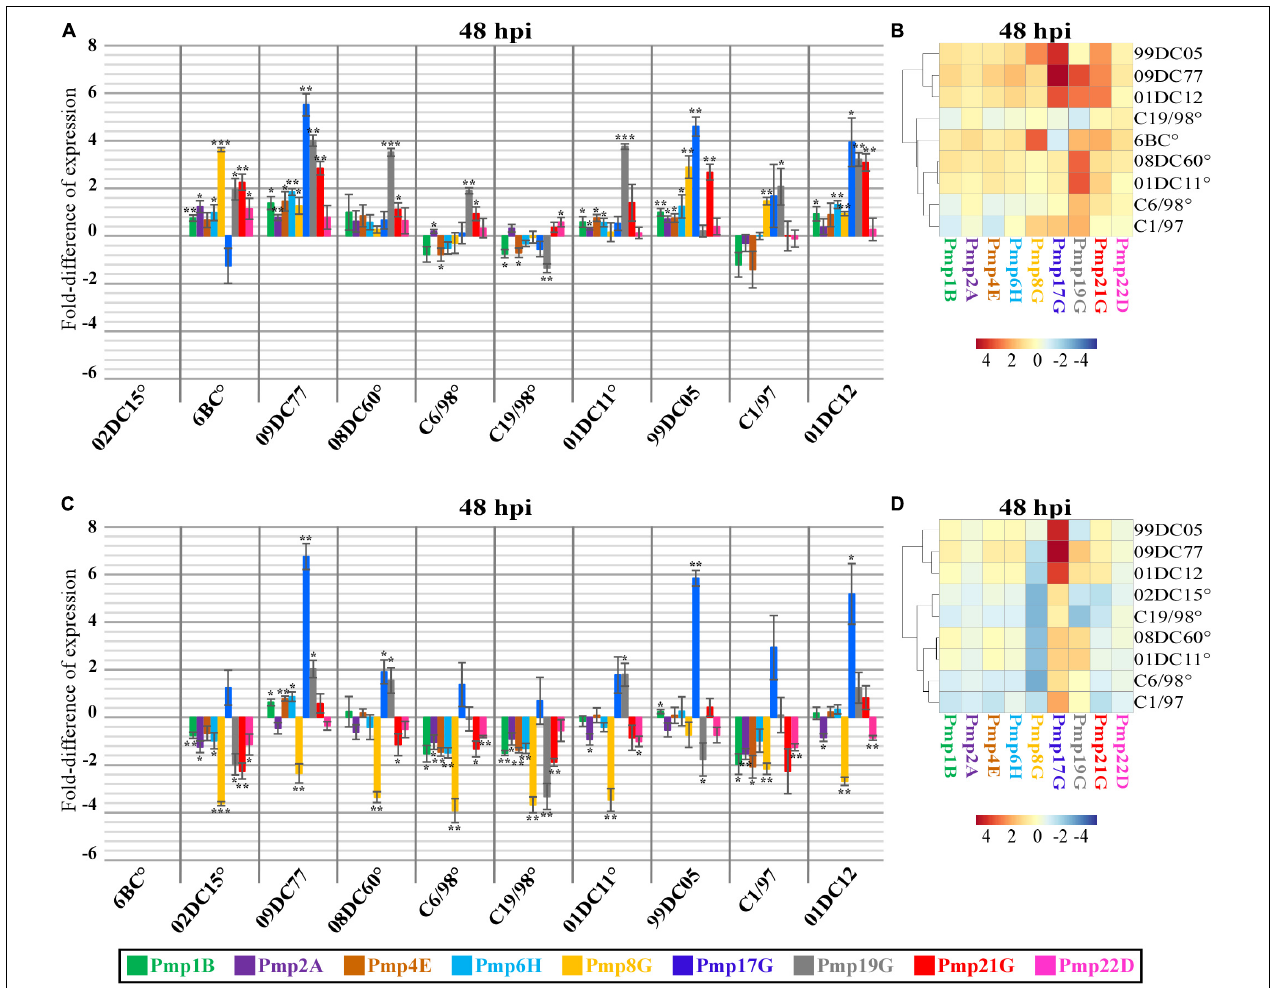
FIGURE 3 | Expression profiles of pmp genes in different C. psittaci strains infecting mammalian epithelial (BGM) cells at 48 hpi. Transcript levels of different color-coded pmp genes were measured by RT-qPCR at 48 hpi and expressed as relative fold-difference, compared to the respective pmp gene of mammalian 02DC15 (A,B) or avian 6BC (C,D) reference C. psittaci strains. ◦ : C. psittaci strains belonging to genotype A. Relative expression levels represent the mean of three independent biological replicates ( n = 3). (A–C) Fold-difference of relative expression for each pmp in each strain is shown in color-coded columns, with the error bars representing the standard deviation of the mean. p -values were calculated using One-way ANOVA and post hoc t-test. * p < 0.05, ** p < 0.001, *** p < 0.0001. (B–D) Expression heat maps illustrate the fold-difference of relative expression for each pmp in each strain. The strains are grouped according to their pmp expression pattern relative to those of 02DC15 or 6BC. Shades of red-colored cells represent folds of expression higher than the respective pmp gene in the reference strains, while shades of blue-colored cells represent folds of expression lower than the respective pmp gene in the reference